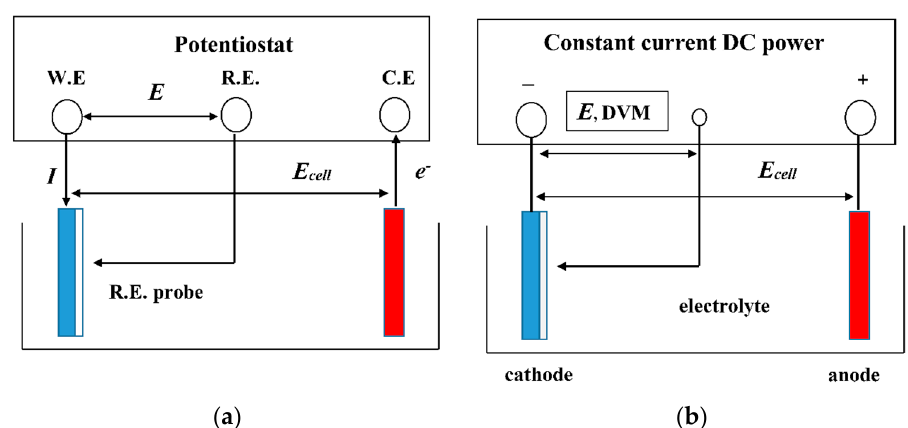
Figure 7. Electrical control of, and connections to, an electrodeposition cell: ( a ) Potentiostatic control, where the cathode is connected as the working electrode of a potentiostat, which controls the working electrode potential with respect to a reference electrode and monitors this potential, E and the current, I flowing through the WE. It is useful to monitor the cell voltage, E cell using a digital voltmeter, DVM. ( b ) galvanostatic control of the current, I , where the cathode and anode are directly connected to the negative and positive terminals, respectively, of a DC power supply. It is useful to incorporate a reference electrode in the cell to facilitate measurement of the potential, E between the WE and RE, using a high impedance DVM.